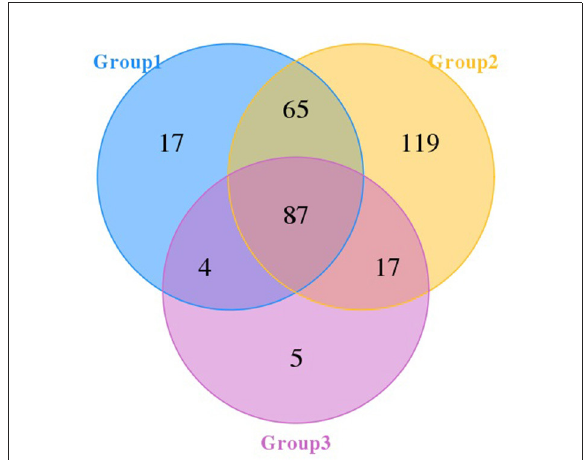
FIGURE1 Venn diagram of pangolins. The number in each independent or overlapped area represents the number of unique or common features in each corresponding collection.